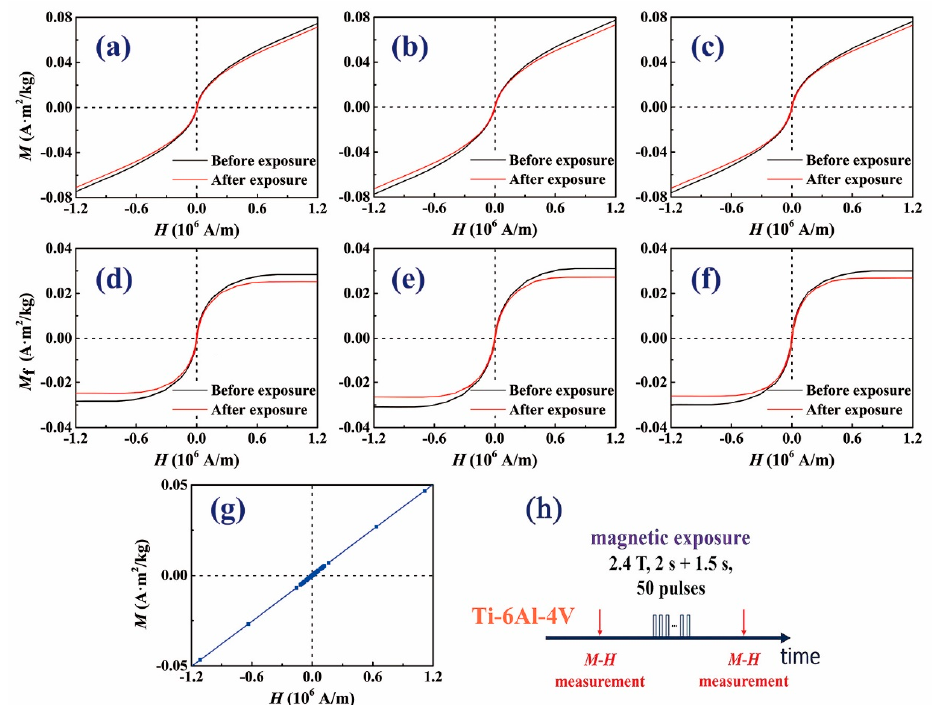
Figure 8. ( a – c ) The magnetization curves of the Ti-6Al-4V specimens and ( d – f ) the ferromagnetic components of the magnetization curves before and after magnetic exposure; ( g ) the magnetization performance of high-purity titanium with a purity of over 99.995 wt %; ( h ) the operation procedures of Ti-6Al-4V specimens.